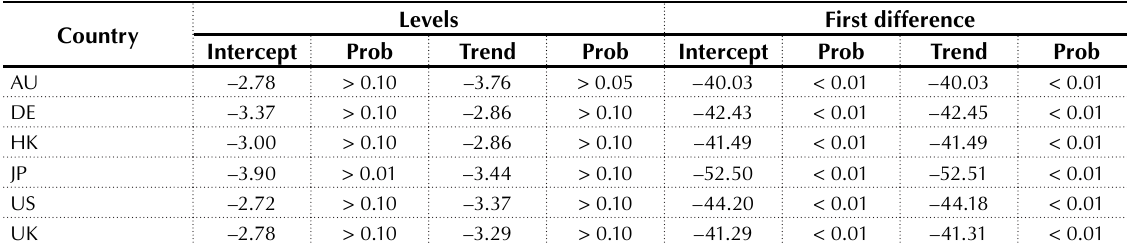
Table 2. Unit root tests with a breakpoint (ADF) on index levels and first